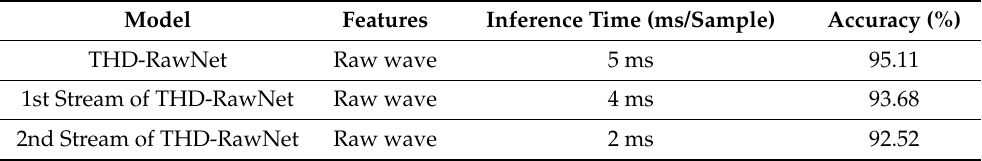
Table 5. Performances of the proposed THD-RawNet and its two